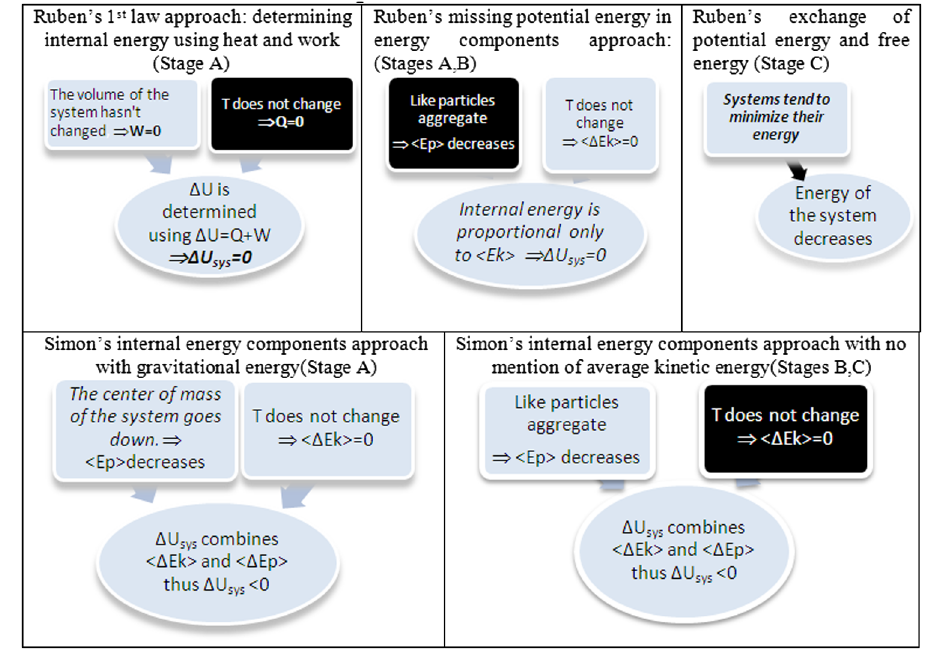
FIG. 3 (color online). Ruben’s and Simon’s various attempts at explaining the changes in internal energy. Missing resources are shaded in black, fragmented or partial resources are